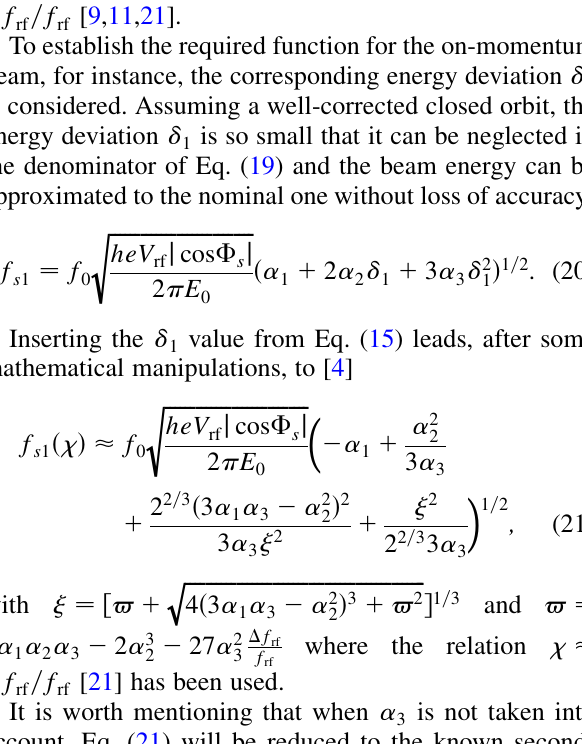
FIG. 6. Measured variation of the synchrotron frequency with respect to the relative variation in the rf frequency. The dots are the measurement data with their error bars of (cid:4) 10 Hz . The solid curve corresponds to a fit of Eq. (21) in the case of a (cid:1)= 100 low- (cid:1) optics: (cid:1) 1 ¼ 5 : 0 (cid:1) 10 (cid:2) 6 (cid:4) 4 (cid:1) 10 (cid:2) 7 , (cid:1) 2 ¼ (cid:2) 1 : 8 (cid:1) 1 : 1 (cid:1) 10 (cid:2) 1 (cid:4) 2 (cid:1) 10 (cid:2) 2 10 (cid:2) 4 (cid:4) 4 (cid:1) 10 (cid:2) 5 , and (cid:1) 3 ¼